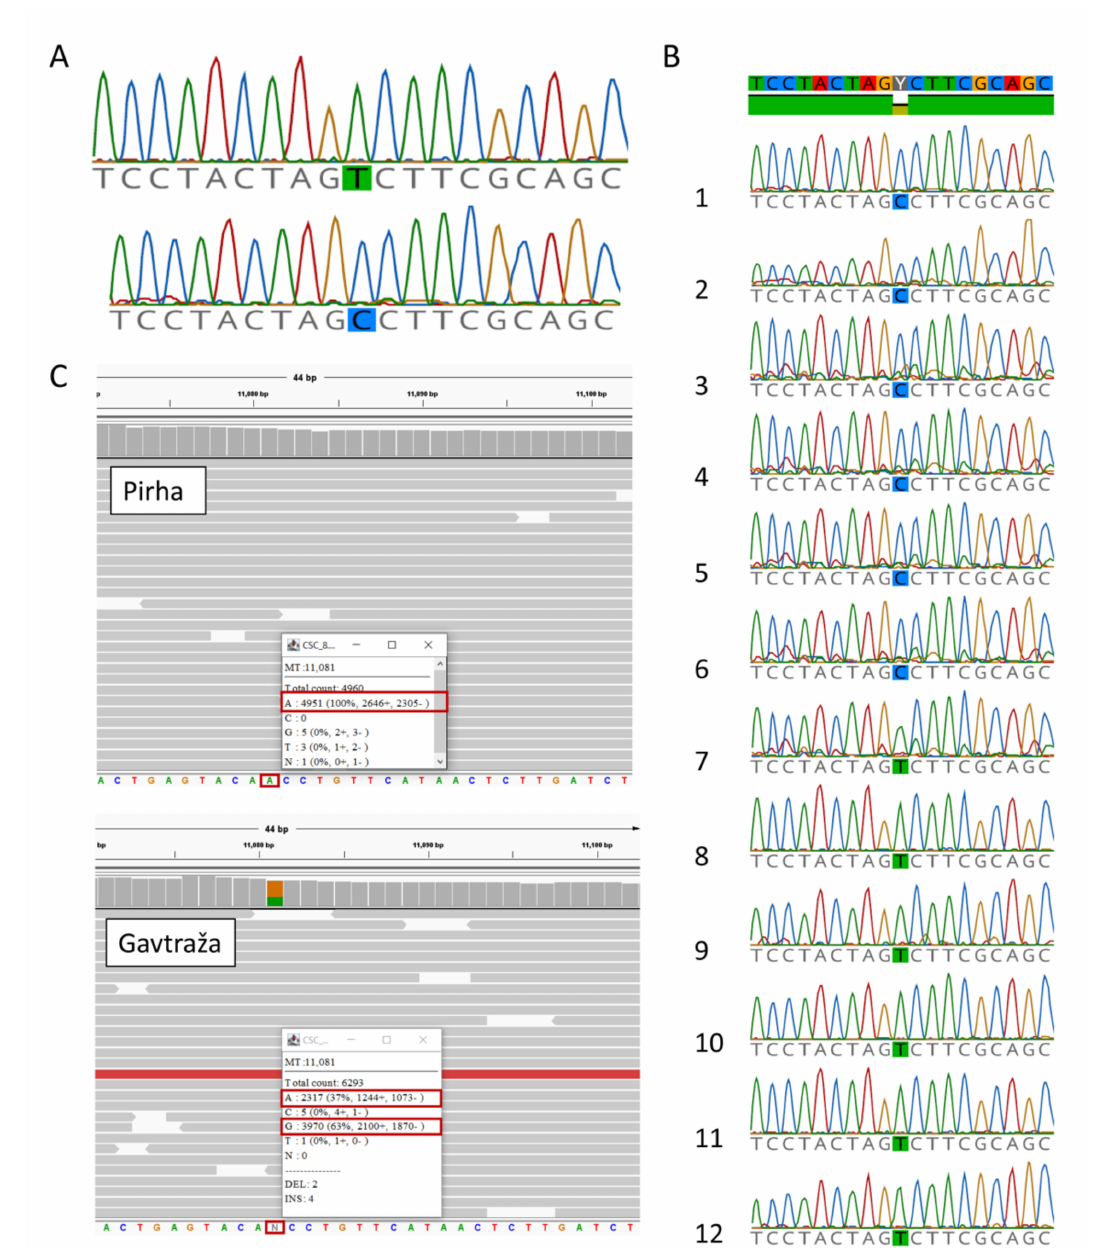
Figure 2. Sequencing of mtDNA revealed two mutations in Cika cattle. ( A ) Homoplasmic mutation T/C at mtDNA position 10,432 confirmed by Sanger sequencing. ( B ) The mutation (C allele) was found in two maternal lineages (Gavtraža and Pirha). The wild type (T allele) was present in all individuals not maternally related to Gavtraža and Pirha. Sequences of mutant and wild-type mtDNA around position 10432: (B1) Gavtraža’s sequence from the muscle tissue; (B2) Gavtraža’s sequence from the brain; (B3) Breza’s sequence; (B4) Košuta’s sequence; (B5) Cow 9502 (cid:48) s sequence; (B6) Cow 9505 (cid:48) s sequence; (B7) Holstein–Friesian control sample’s sequences; (B8–B12) Cika individuals not maternally related to Gavtraža and Pirha. All the sequences shown from B3 to B12 were obtained from blood cells. ( C ) NGS sequencing of the whole mitochondrial genome revealed an additional heteroplasmic mutation in Gavtraža (A/G) at position 11,081 bp, but not in